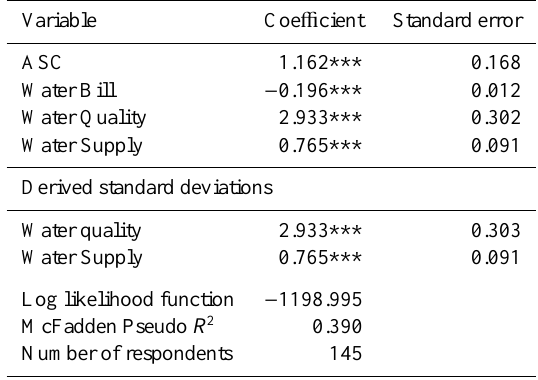
Table 3. Random parameter logit